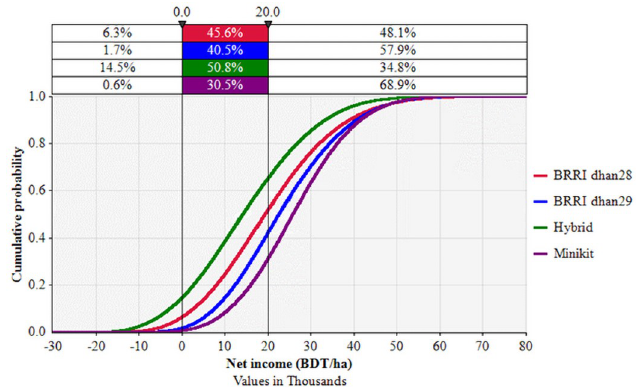
Fig 8. Cumulative probability distribution of net income of different Boro varieties during 2015–16 to 2016–17 in northwest Bangladesh.